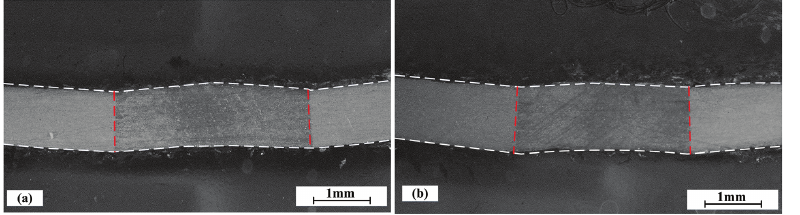
Figure 12: Weld stereomicroscope images under different welding speeds of (a) sheet No. 9 and (b) sheet No.